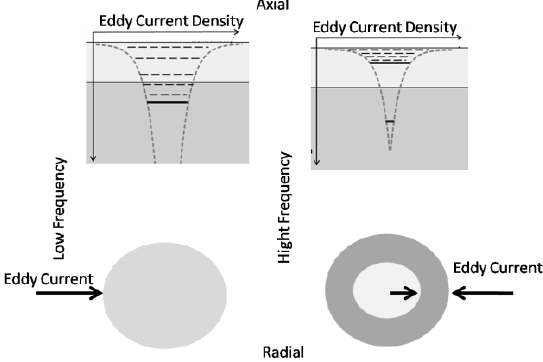
Figure 2. Skin e ff ect illustration in low and high Figure 2. Skin effect illustration in low and high frequency.